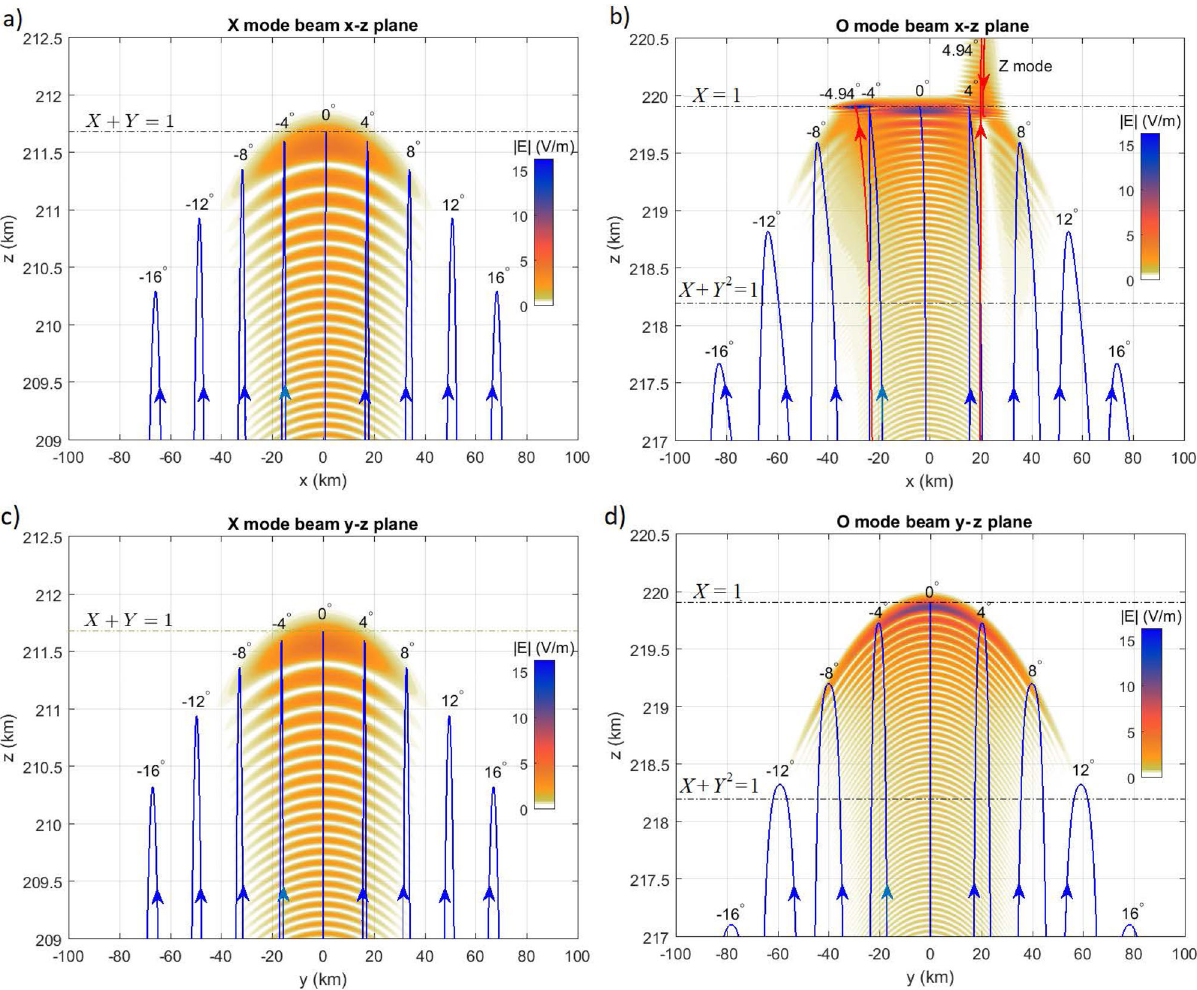
Fig. 5 Wave structures near X and O mode re fl ection points. Vertically injected a , c X mode and b , d O mode beams of frequency 6.3 MHz and width 6 : 9 (cid:4) (cf. Table 1), a , b in the magnetic meridian ( x - z ) plane including the magnetic fi eld and c , d in the y - z plane, at t < 1 ms, before the onset of parametric instabilities. Solid lines show ray paths at different incidence angles θ . Red lines in panel ( b ) indicate rays injected at the Spitze angle þ 4 : 94 (cid:4) where the O mode is absorbed and converted to Z mode (slow X mode) waves and at (cid:1) 4 : 94 (cid:4) to electrostatic Langmuir waves. Horizontal dash-dotted lines show the altitudes of the X mode cutoff X þ Y ¼ 1 at z ¼ 211 : 68km, the critical layer X ¼ 1 at z ¼ 219 : 91km, and the upper hybrid resonance X þ Y 2 ¼ 1 at z ¼ 218 : 20km. The color scale shows the RMS magnitude E j j of the wave electric fi eld. The vertical and horizontal axes are set to different scales for